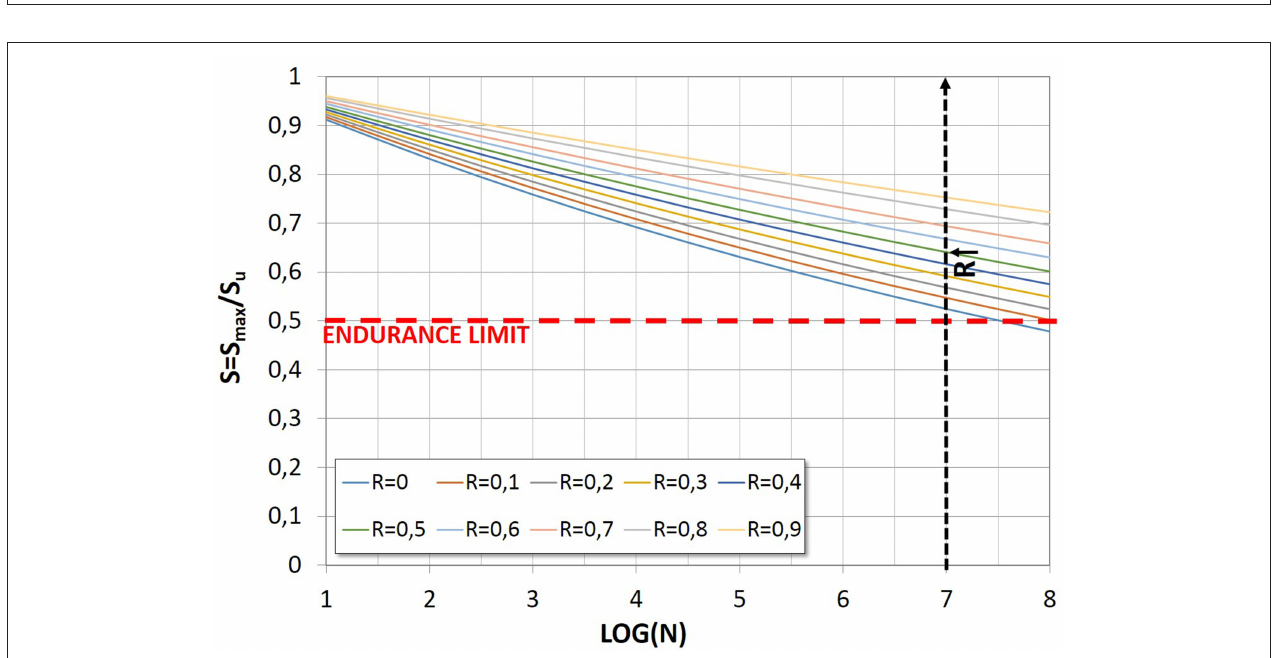
FIGURE 3 | Tomor and Verstrynge (2013) fatigue curves, referred to a 5% of failure